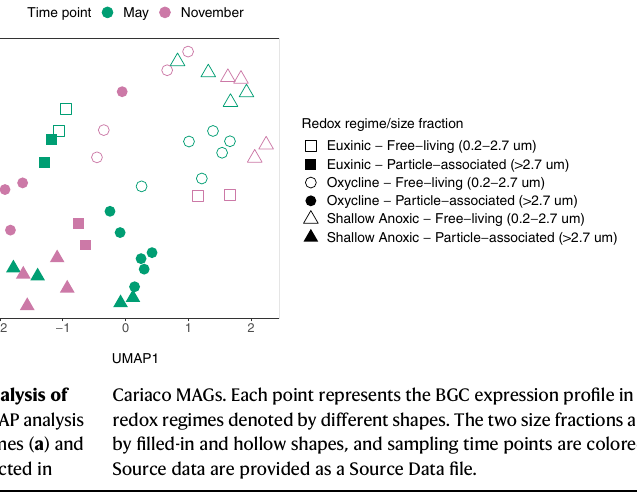
Cariaco MAGs. Each point represents the BGC expression pro fi le in a sample, with redoxregimes denotedby differentshapes. Thetwo sizefractionsare represented by fi lled-in and hollow shapes, and sampling time points are colored differently. Source data are provided as a Source Data fi